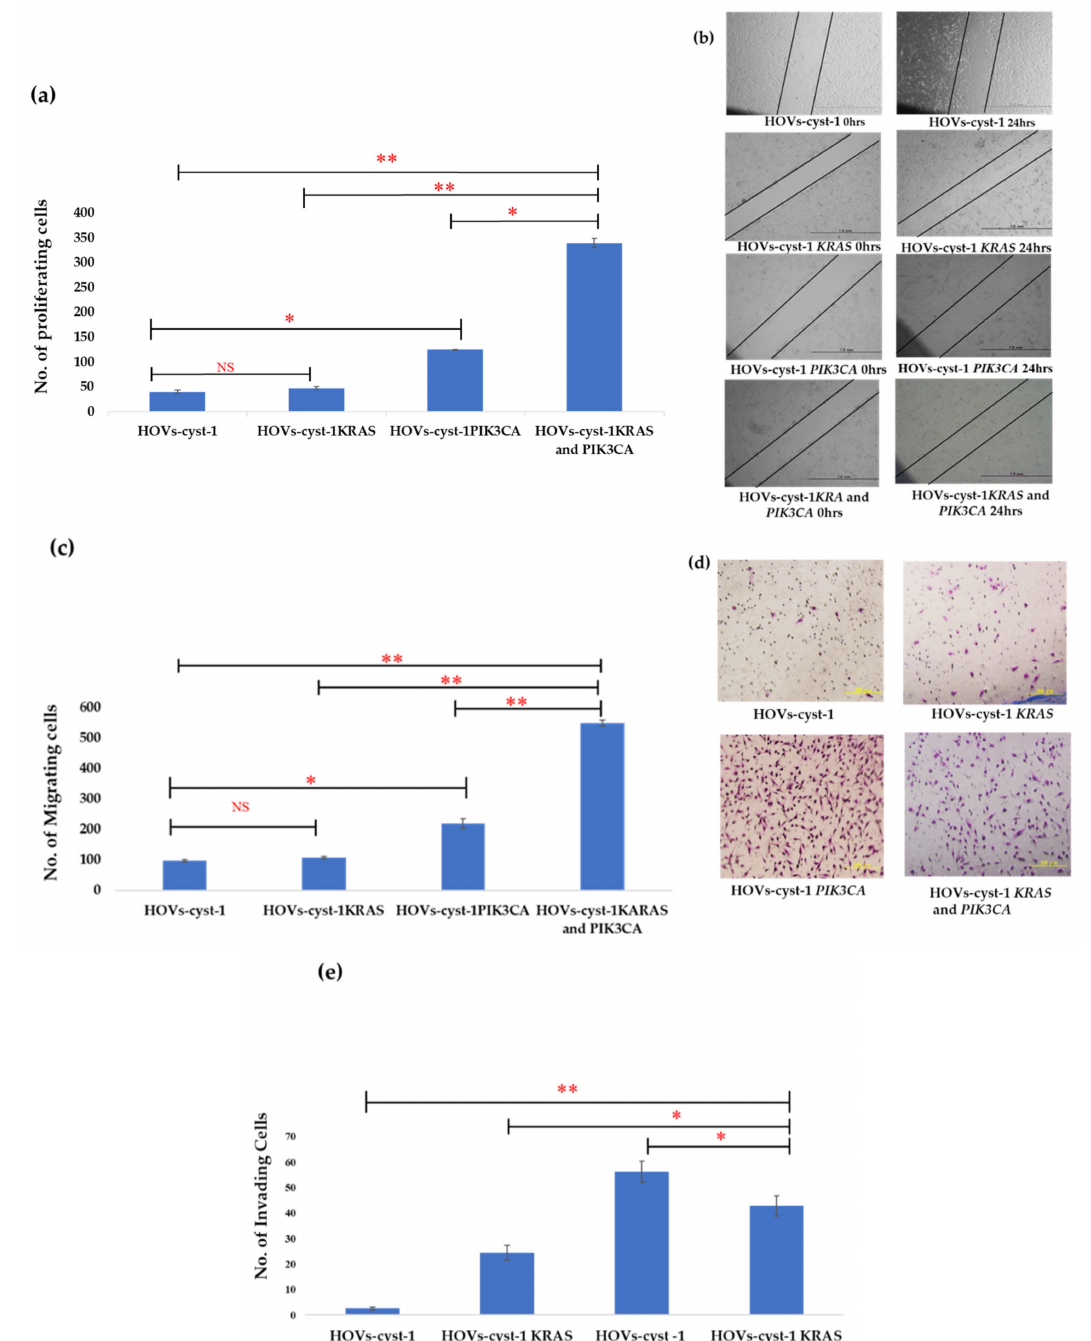
Figure 3. Proliferation of HOVs-cyst-1 cells. ( a ) Proliferation capability of HOVs-cyst-1cells, with both KRAS and PIK3CA mutations (significantly higher than those of HOVs-cyst-1 cells or HOVs-cyst-1 cells, with either KRAS or PIK3CA mutation; * p < 0.05, ** p < 0.01). ( b , c ) Migration ability of cells based on wound healing assay. HOVs-cyst-1 cells, with both KRAS and PIK3CA mutations, showed higher cell migration ability than HOVs-cyst-1 cells or HOVs-cyst-1, with either KRAS or PIK3CA mutation. The photographs were taken immediately after the scratch (0 h, upper left panel) and 24 h after the scratching (upper right panel). ( d , e ) Invasion rates of cells based on Matrigel invasion assay. HOVs-cyst-1 cells, with PIK3CA mutation, and HOVs-cyst-1 cells, with both KRAS and PIK3CA mutations, showed higher invasion rates than the other cells (* p < 0.05, ** p < 0.01). The error bar indicates the standard deviation. (NS; no significant difference; * p < 0.05, ** p <